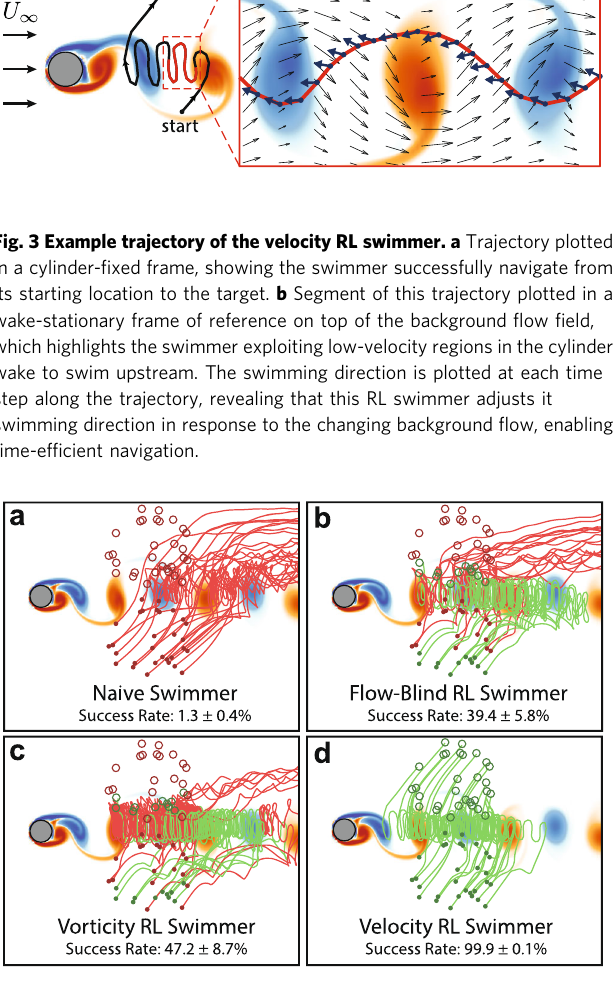
Fig. 4 Average success rate with 30 example trajectories for each swimmer type. Successful attempts to reach the target are green, while unsuccessful attempts are red. a Naive policy of swimming towards the target is rarely successful. b The fl ow-blind RL swimmer navigates more effectively than the naive swimmer. c The vorticity RL swimmer is more successful than the fl ow-blind swimmer, showing that sensing the local fl ow can improve RL-based navigation. d Surprisingly, the velocity RL swimmer nearly always reaches the target using only the local fl ow velocity. The stated success rates are averaged over 12,500 episodes and are shown with one standard deviation arising from the fi ve times each swimmer was trained.